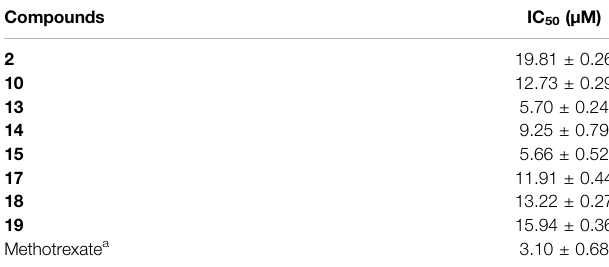
TABLE 4 | ｜ Effects of compounds 2 , 10 , 13 – 15 , and 17 – 19 on rheumatoid arthritis fi broblast-like synoviocytes.